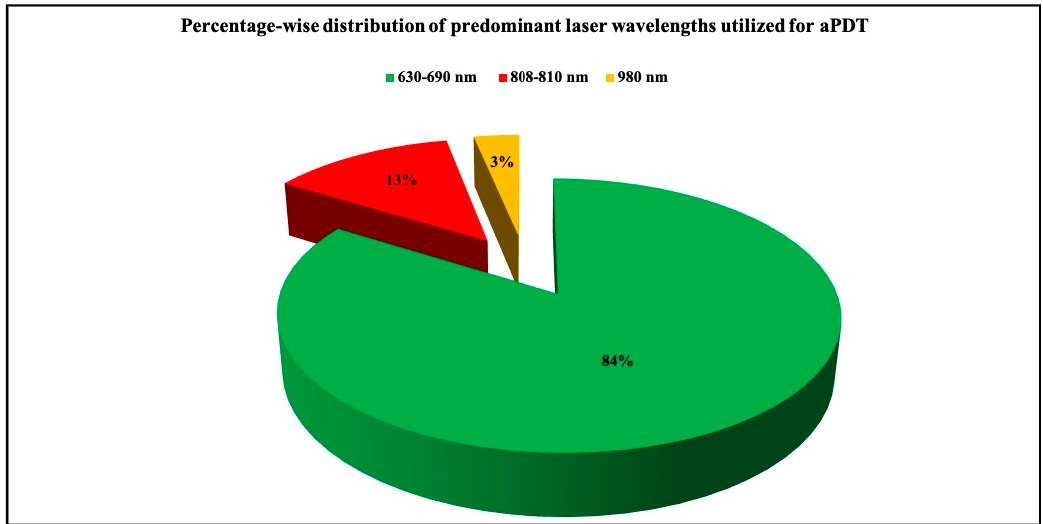
Figure 2. 3D pie diagram illustrating the percentage-wise distribution of predominant laser wavelengths utilized for aPDT in the included studies.